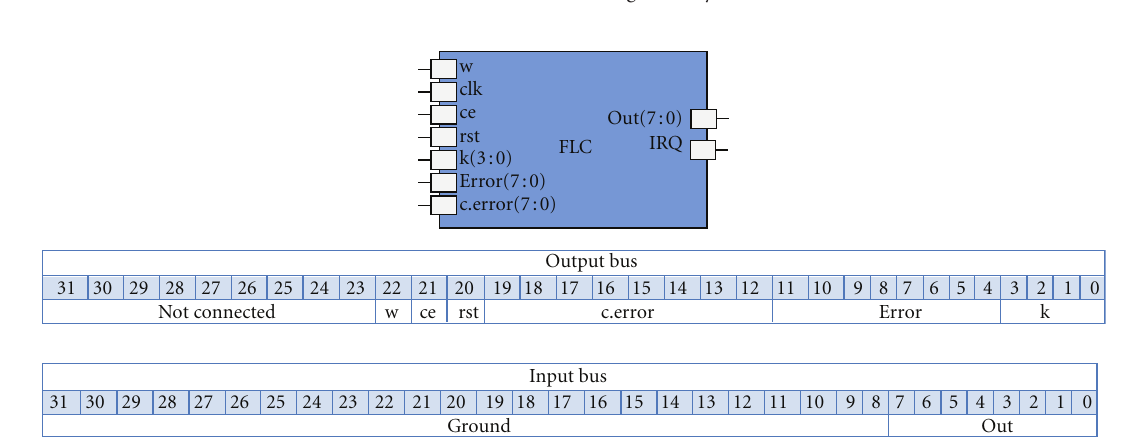
Figure 5: Overview of the general system.